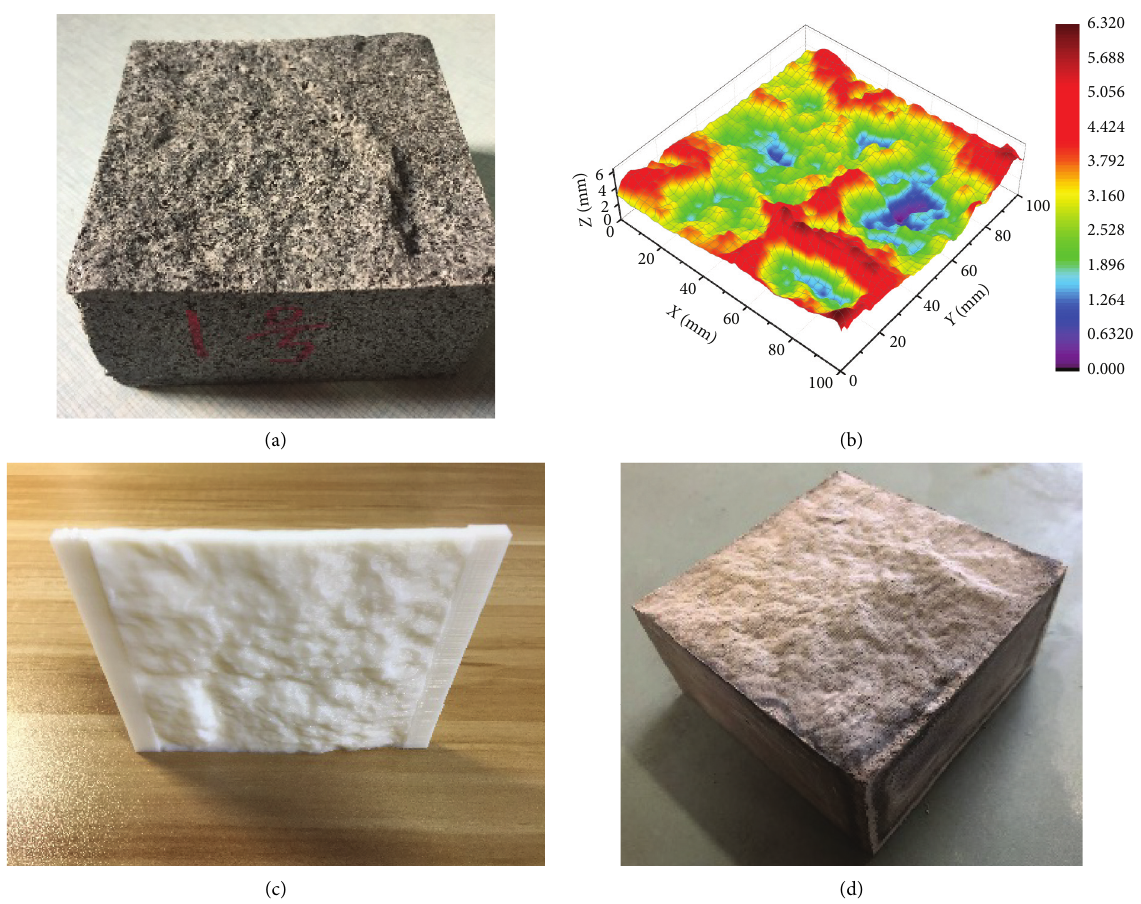
Figure 13: The two joint specimens used to evaluate roughness. (a) Natural joint sample. (b) Joint surface model. (c) Joint surface mold. (d) Mortar joint specimen.